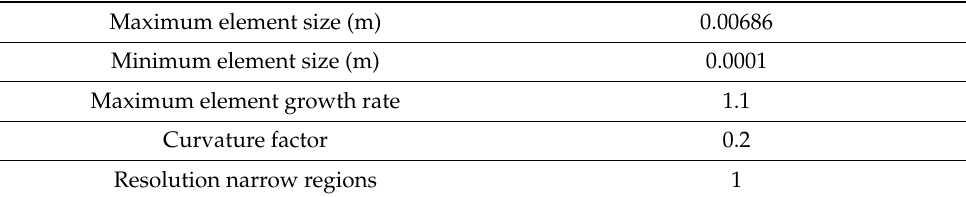
Table 3. Parameters of the grid system in